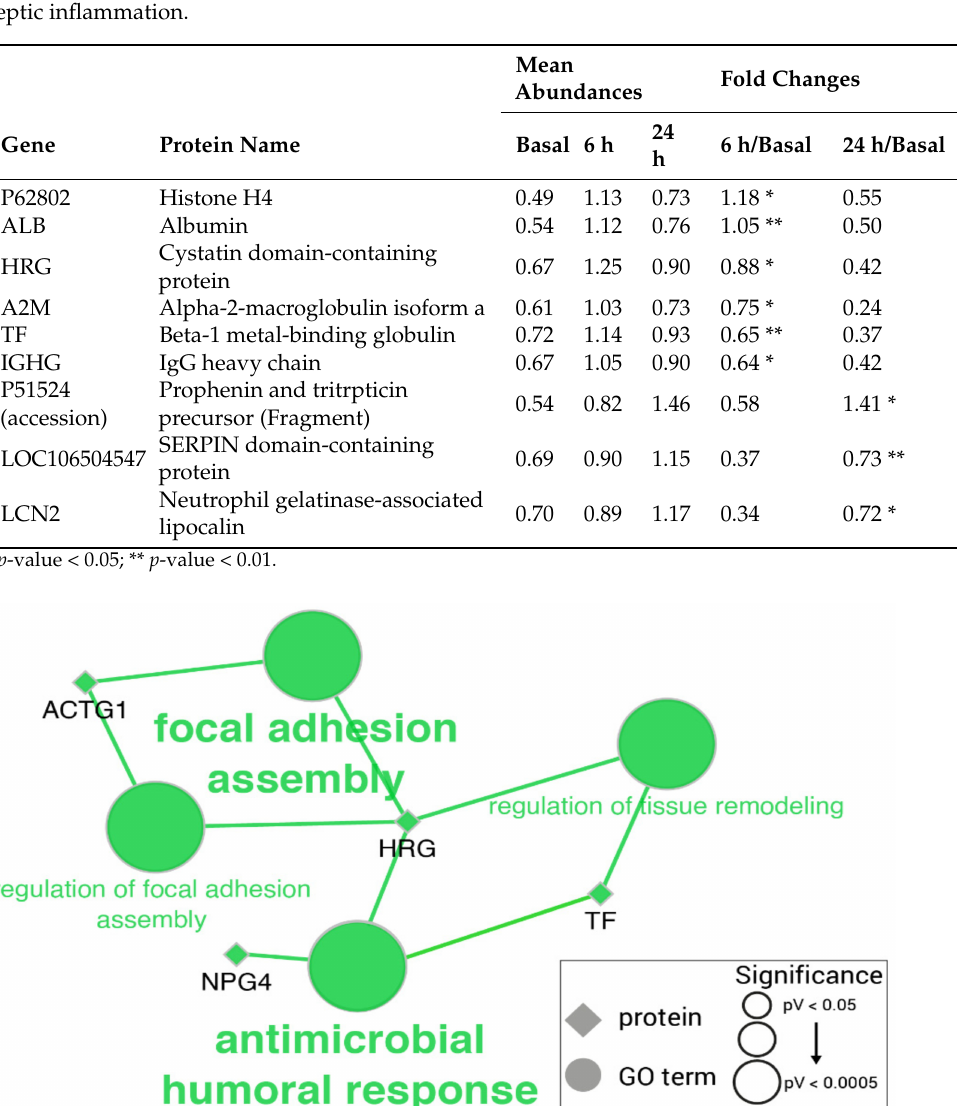
Figure 3. Significantly enriched GO terms among differentially expressed proteins in the saliva of pigs with non-septic inflammation. Edges link proteins (diamonds) to their associated GO terms (circles). Proteins colored in green are overexpressed. GO terms are colored accordingly to the proportion of over-/down-expressed proteins. GO term shape and font size is proportional to GO term significance, but all included ones showed a p value <